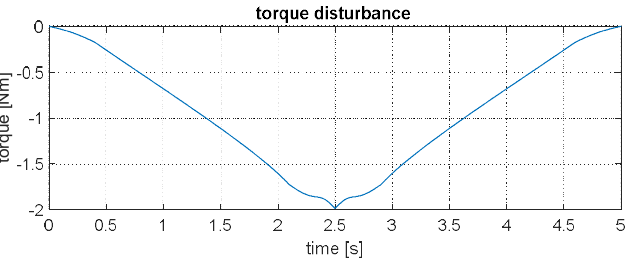
Figure 7. Manipulator ( top ) and UAV ( middle ) motions, and torque disturbance ( bottom ) for the ideal 2-DOF trolley case.